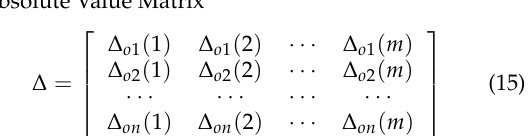
Step 5: Calculation of the grey relational coefficient. Using Eq. (16), the grey relational coefficient is calcu- lated.